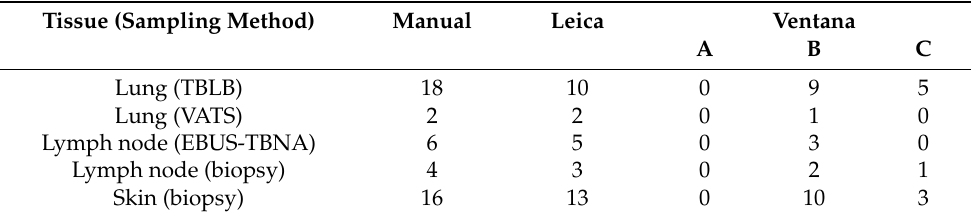
Table 4. Number of tissue samples with P. acnes detected in sarcoid granulomas by manual and automated immunohistochemistry methods. Tissue (Sampling Method) Manual Leica